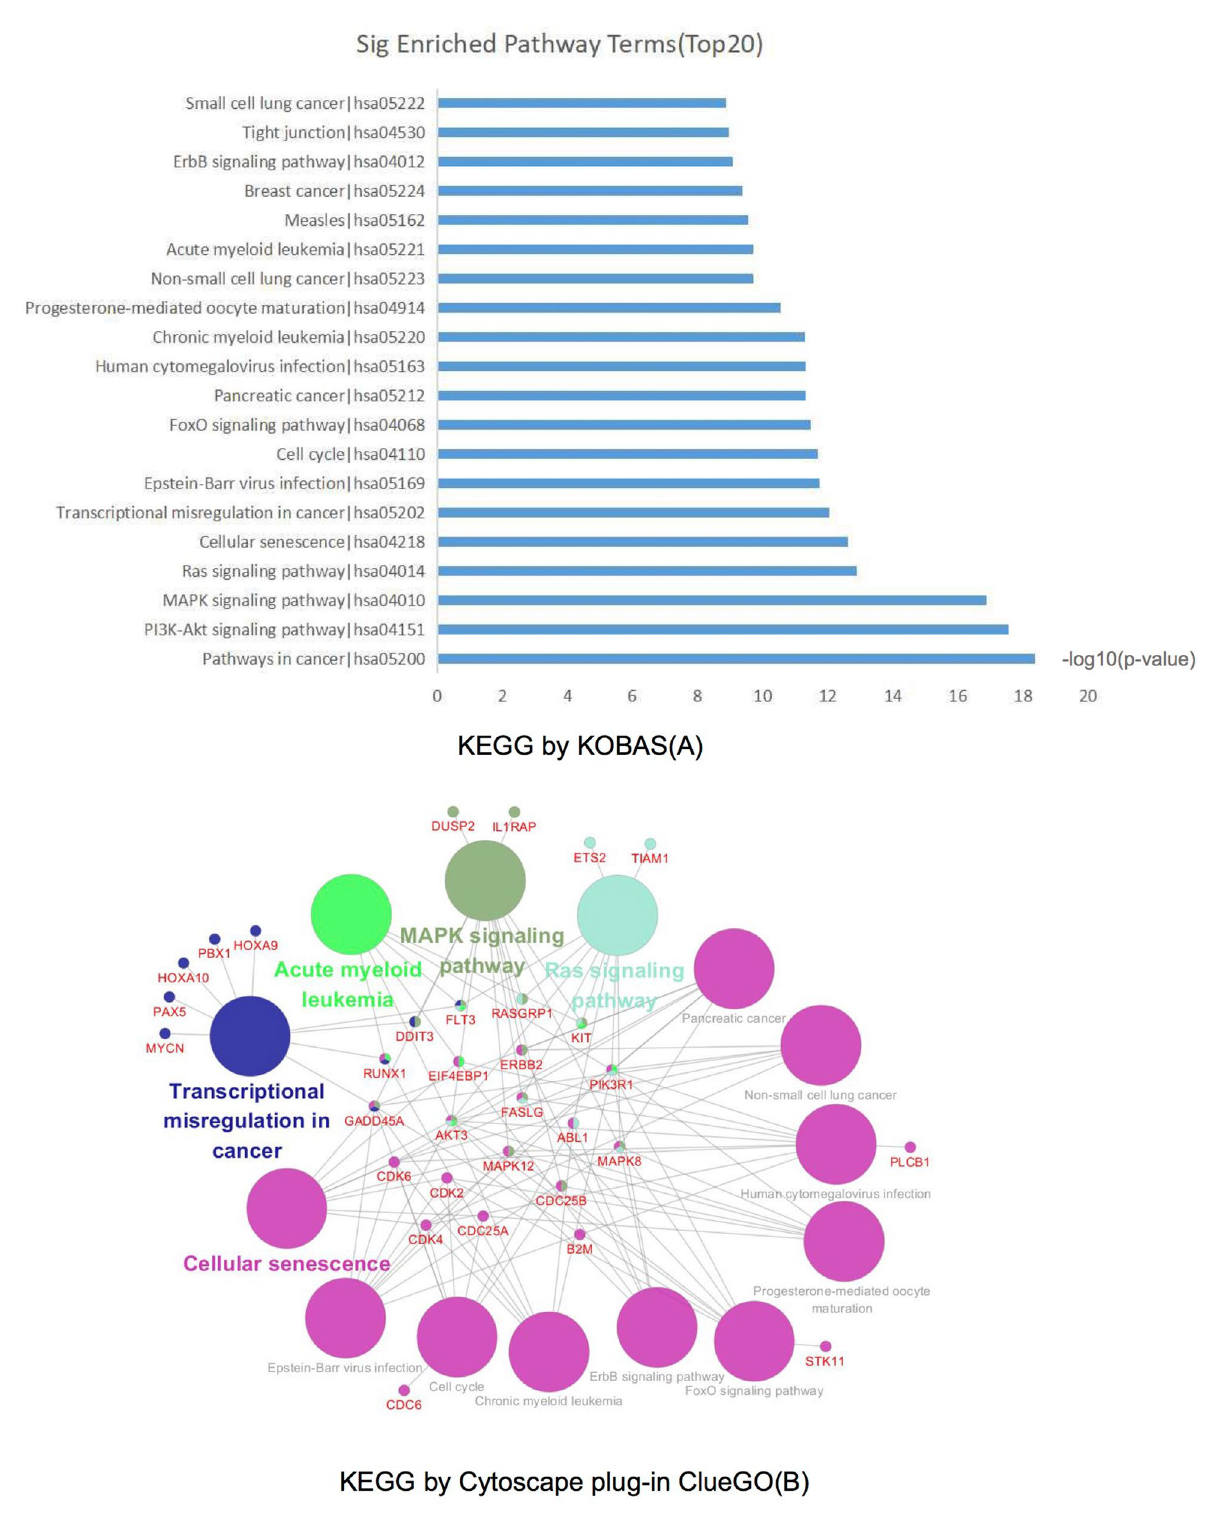
Figure 5. Gene Ontology analysis and significantly enriched GO terms of DEmRNAs in the lncRNA–miRNA– mRNA network. ( A ) Significantly enriched GO terms of DEmRNAs in the lncRNA–miRNA–mRNA network based on their functions. ( B ) GO analysis classified DEmRNAs in the lncRNA–miRNA–mRNA network into 3 groups (i.e., molecular function, biological process and cellular